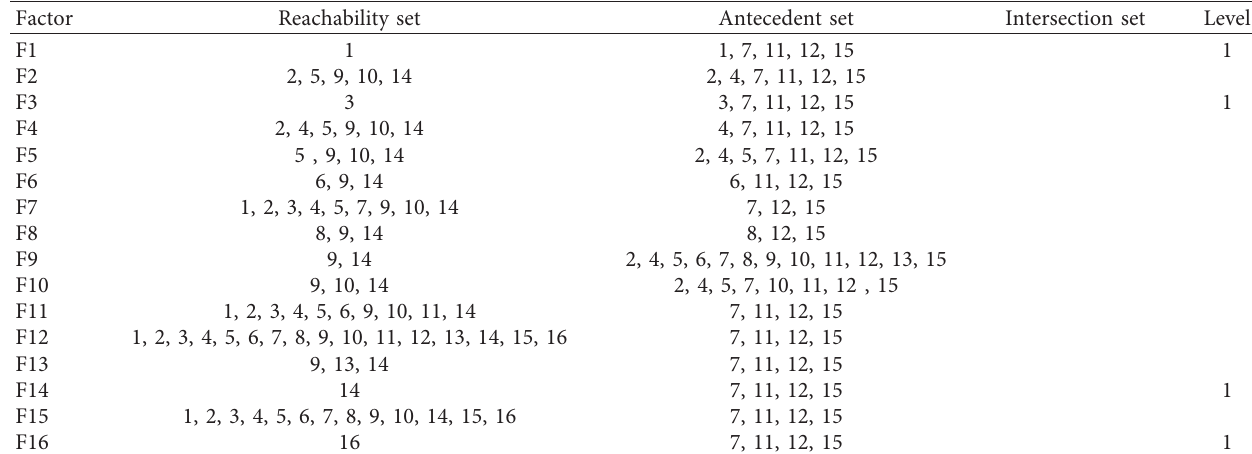
Table 4: Level partitions for level 1.